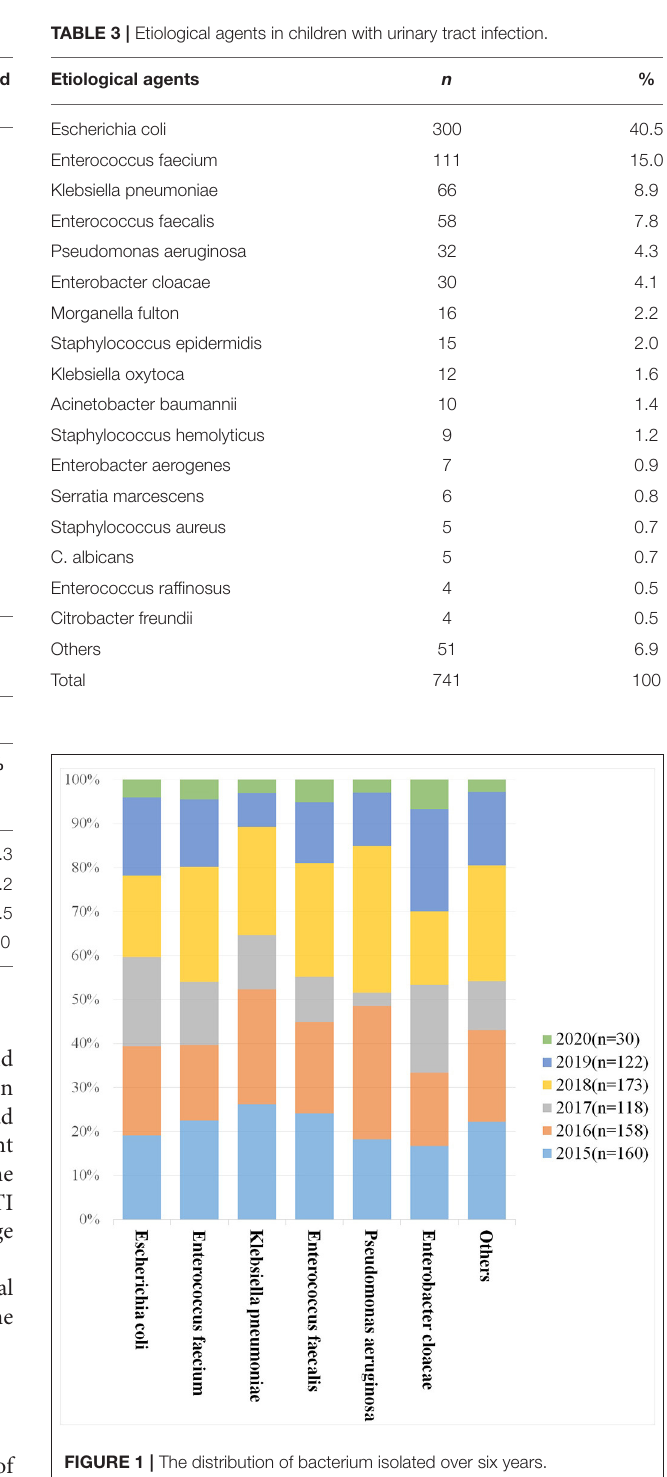
4.1% (30/741) of patients ( Table 3 ). The distribution of bacterium isolated in urine during the study period is depicted in Figure 1